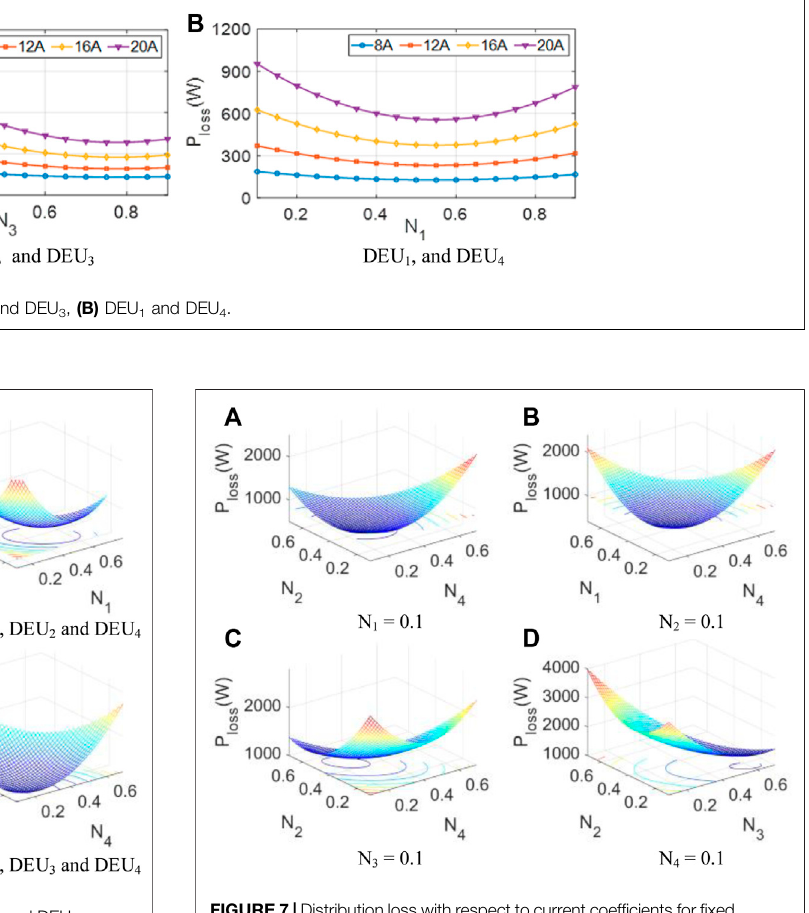
FIGURE 6 | Loss with three DEU systems. (A) DEU 1 , DEU 2 , and DEU 3 , (B) DEU 1 ,DEU 2 ,andDEU 4 , (C) DEU 1 ,DEU 3 ,andDEU 4 , (D) DEU 2 ,DEU 3 ,and DEU